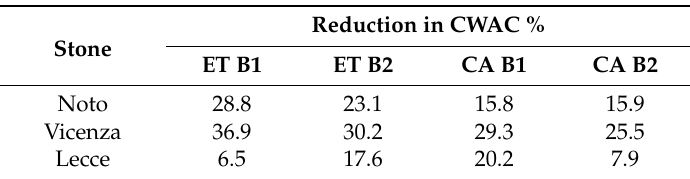
Table 2. Water absorption coefficient, comparison before and after treatment. CWAC, capillary water absorption coefficient.